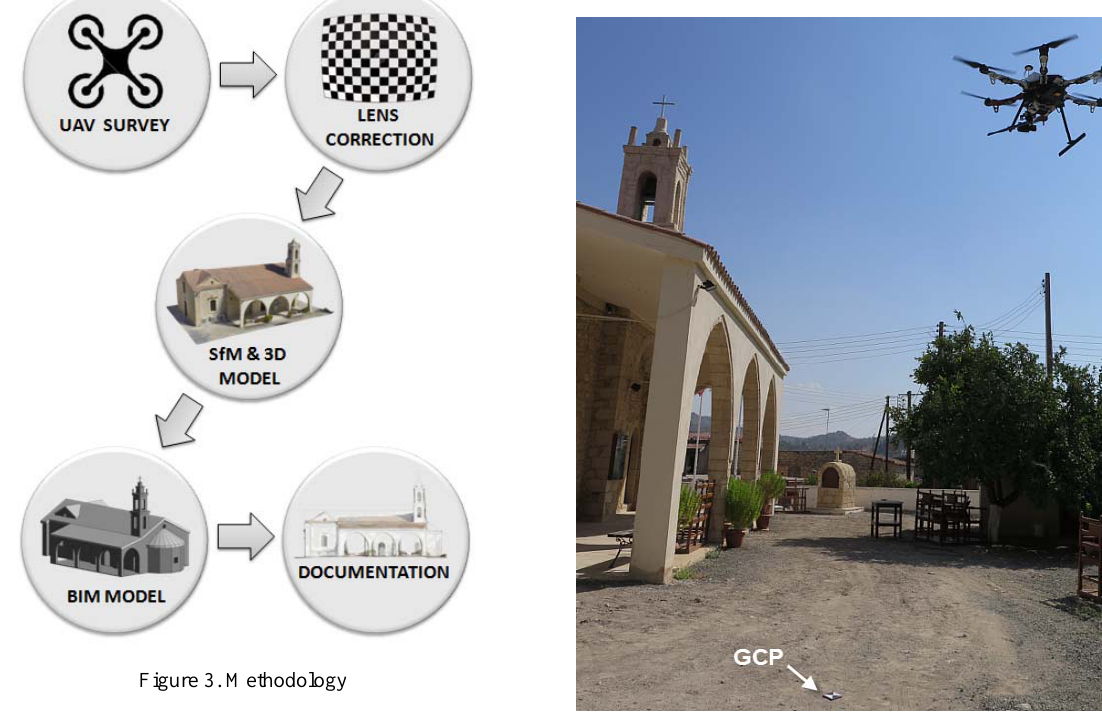
Figure 5. UAV flying over Foinikaria